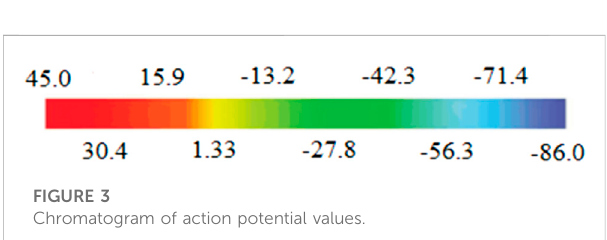
FIGURE 3 Chromatogram of action potential